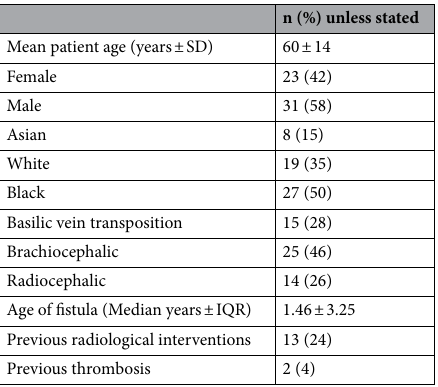
Table 1. Table summarising the demographic information of the 54 patients within this study.